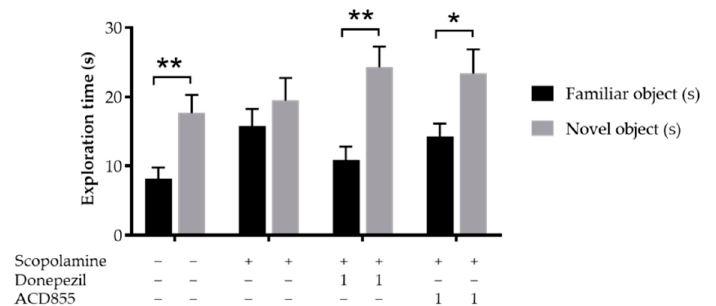
Figure 7. Effects of ACD855 and donepezil on object recognition in Wistar rats. ACD855 was administered for 4 consecutive days using 1 mg/kg, whereas donepezil was administered 30 min before the trial, both in combination with 1 mg/kg scopolamine. Groups treated with scopolamine and donepezil or ACD855 spent significantly greater time with the novel object. Black bars indicate familiar object and grey bars indicate novel object. ** p < 0.01 or * p < 0.05 for time spent on novel objects vs time spen on familiar objects.